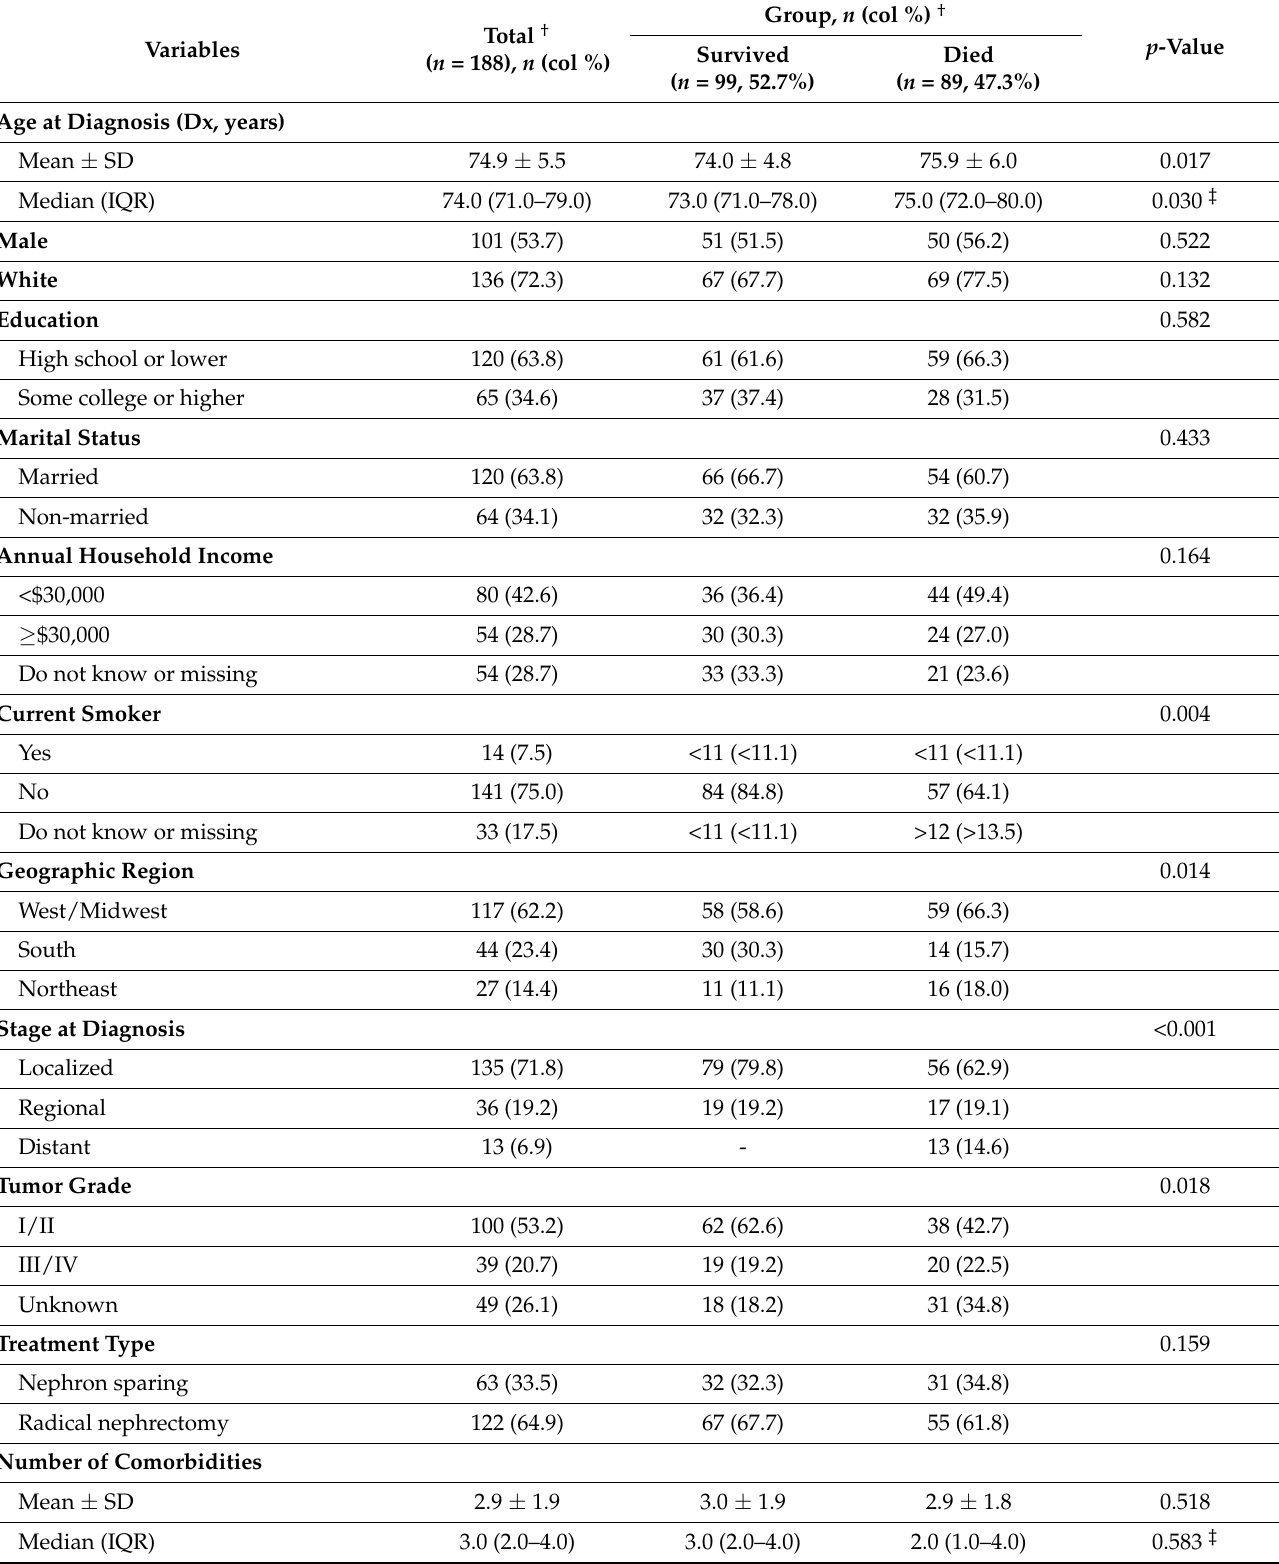
Table 1. Characteristics of patients with kidney